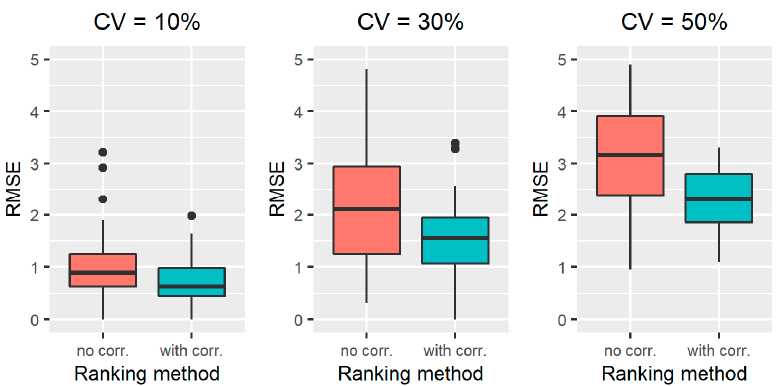
Figure 2. RMSE results obtained for the standard RFE-Borda count method (red boxplot, “no corr.” label) and the proposed algorithm (green boxplot, “with corr.” label) for scenarios 1–3, characterized by noise CV of 10% ( left ), 30% ( middle ) and 50% ( right ).